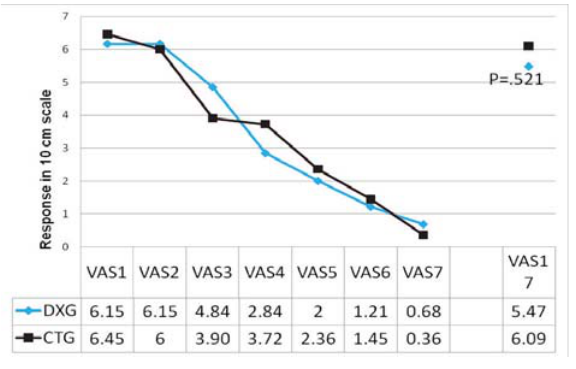
Figure 4. Comparisons of the 7 post-operative days, VAS score between the